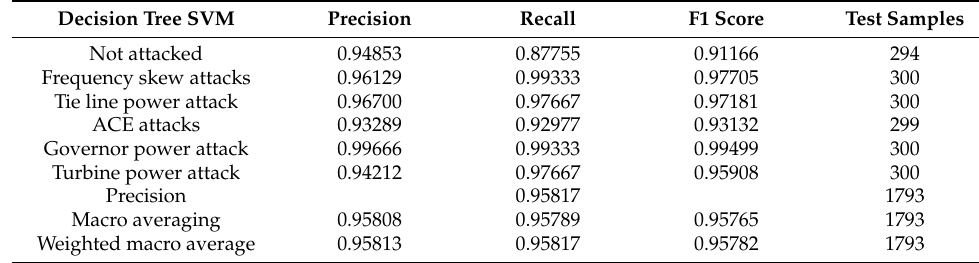
Table A5. The decision tree SVM algorithm trained on model indicator